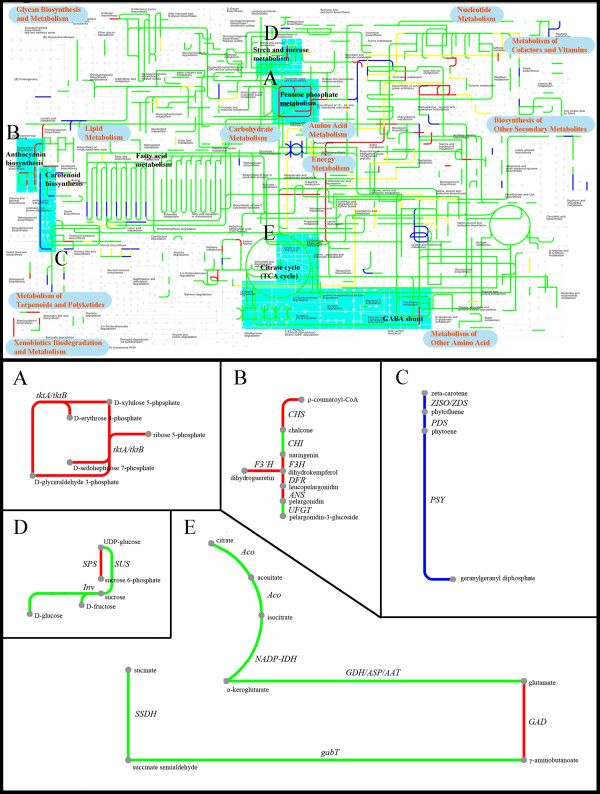
Interactive pathways analysis during bayberry fruit ripening. The green, the red, the blue and the yellow lines indicate genes with non-significant expression change, up-regulated, down-regulated, and irregularly regulated, respectively. The areas with sky blue background indicate the metabolic pathways related to fruit color, sugar and organic acids. (A) Pentose phosphate metabolism, (B) Anthocyanin biosynthesis, (C) The upstream part of carotenoid biosynthesis, (D) Sucrose biosynthesis, (E) GABA shunt.